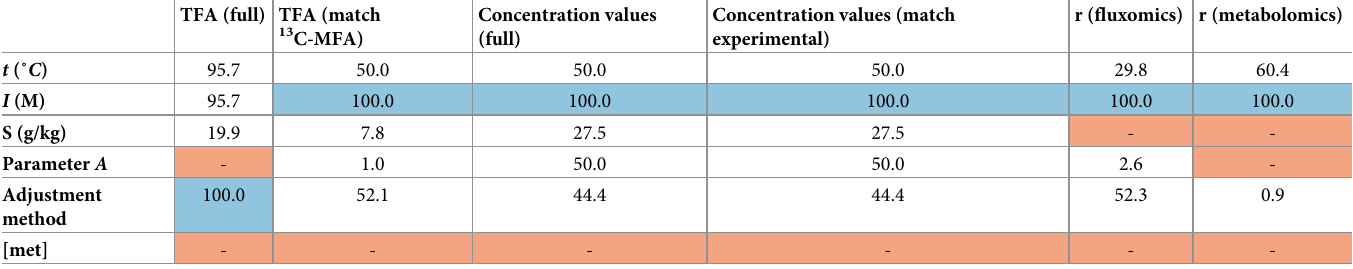
Table 3. Relative factor importance. The type of analysis depended on the nature of the response: classification was selected for TFA (full), TFA (match 13 C-MFA), con- centration values (full) and concentration values (match experimental), and regression for r (fluxomics) and r (metabolomics). The former was suited for categorical responses (i.e. which solution is achieved, as shown in S4 Table), and the latter for continuous responses (for Pearson’s r, from -1 to +1). TFA (full) TFA (match 13